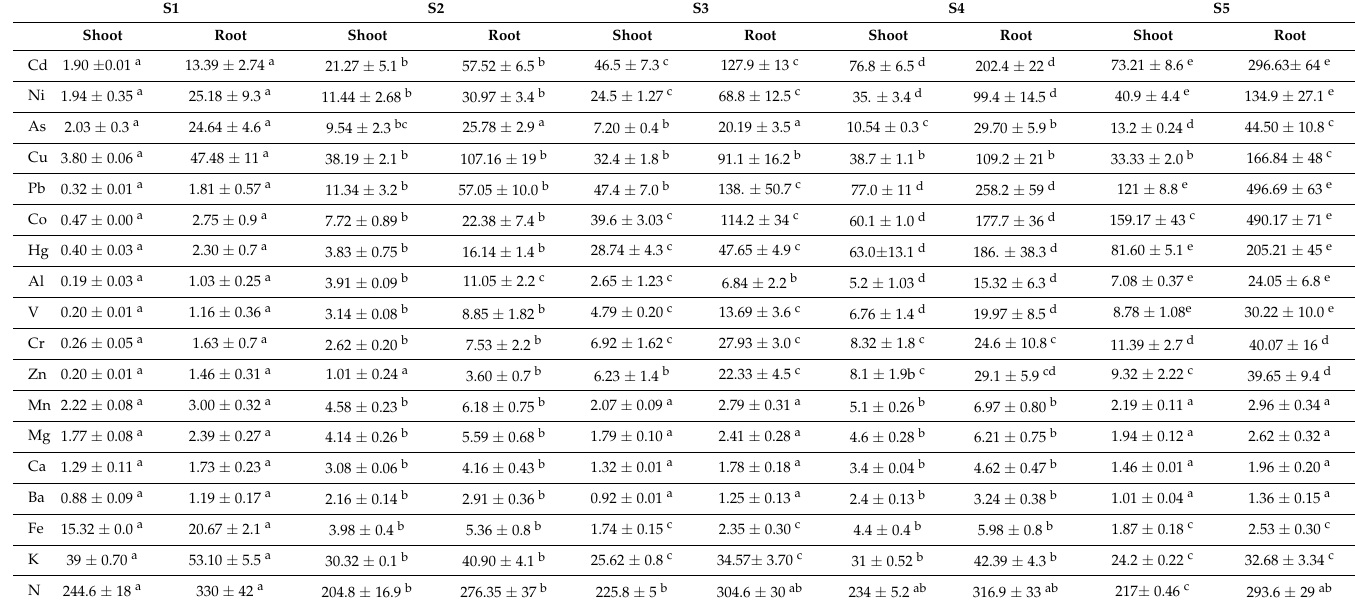
Table 3. Heavy metal concentrations ( µ g/gm) in the shoots and roots of S. portulacastrum grown in control site (site 1) and contaminated sites (site 2–5). Data are mean values ± SE ( n = 4). Different letters (a–e) represent the significant differences between the effect of heavy metal stress in the different target sites (Tukey test ( p < 0.05)).